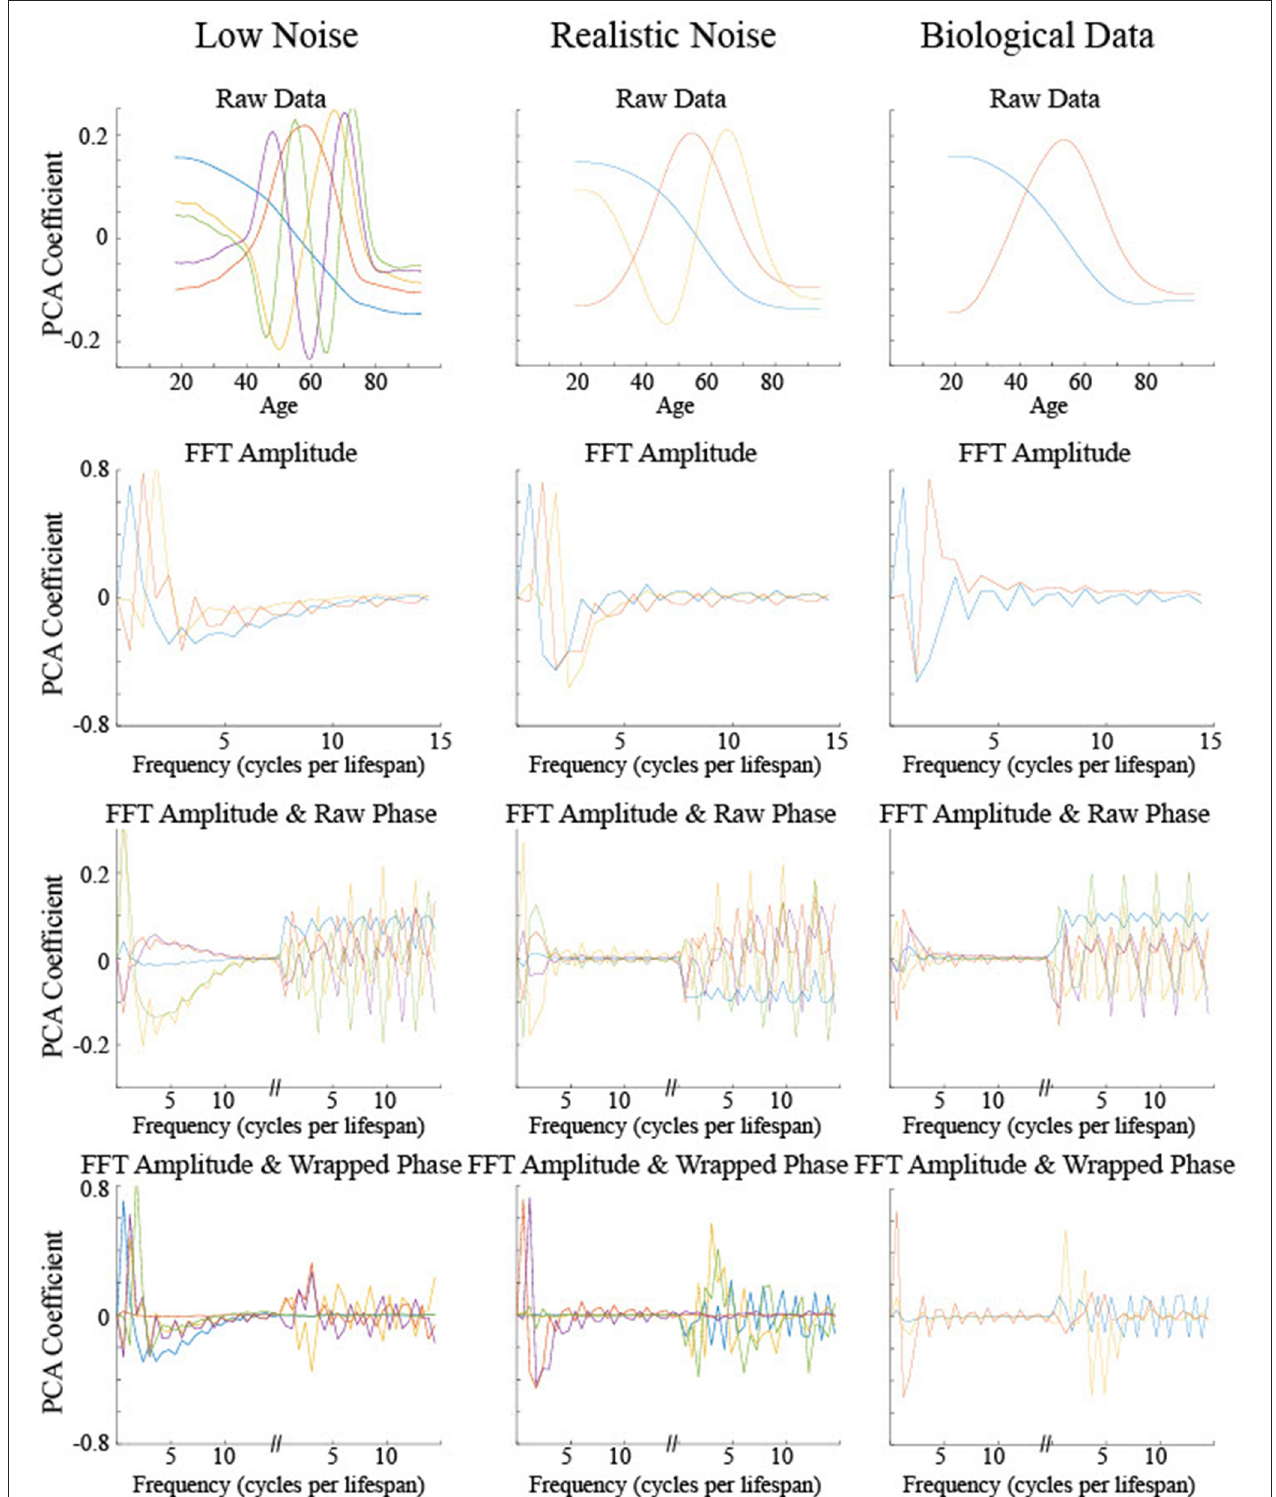
FIGURE 11 | The principal components based on the PCA of four different input types for three different data sets. Only the set of components that accounted for at least 95% of the variance were included or the first five components are shown, whichever was the smaller number. The color of the components indicates the relative proportion of the variance explained by that component, in the following order from most to least: blue, red, orange, purple, and green.